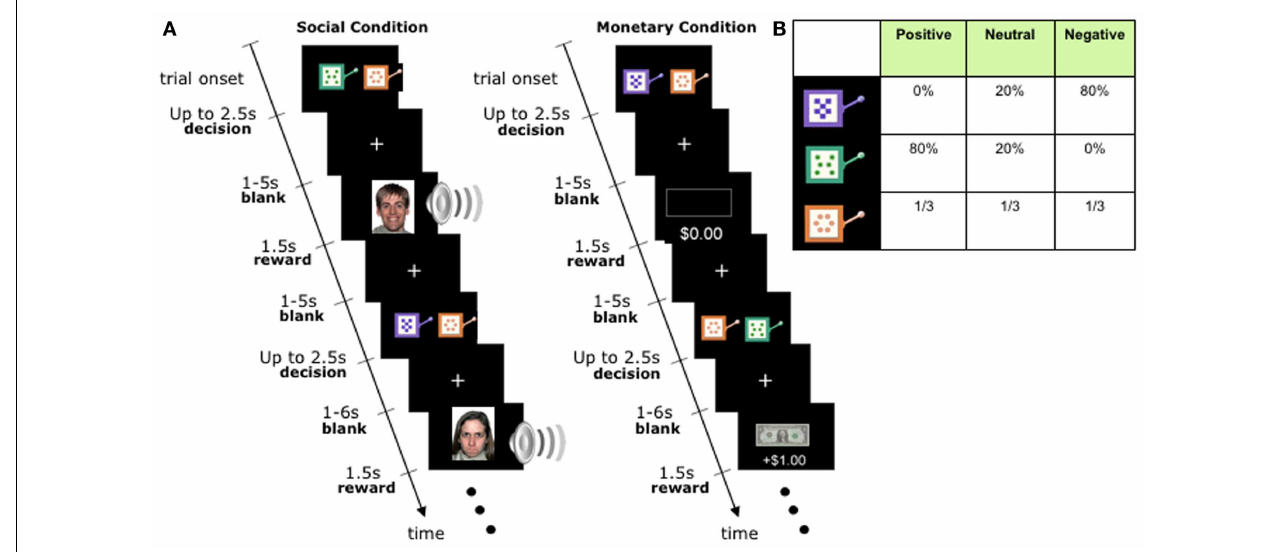
subject, and distinct between monetary and social condition blocks. (B) Distribution of outcomes for each slot machine. First row: negative machine. Second row: positive machine. Bottom row: neutral machine.The same distribution was used in the monetary and social conditions. Actual appearance of the slot machines was randomly paired with a reward outcome distribution, and distinct between monetary and social condition